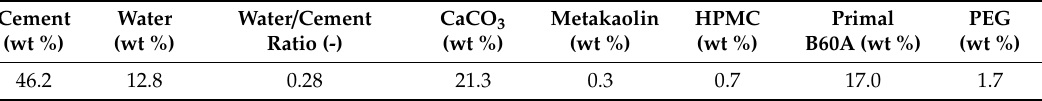
Table 1. Mix design of the polymer-modified cement paste.